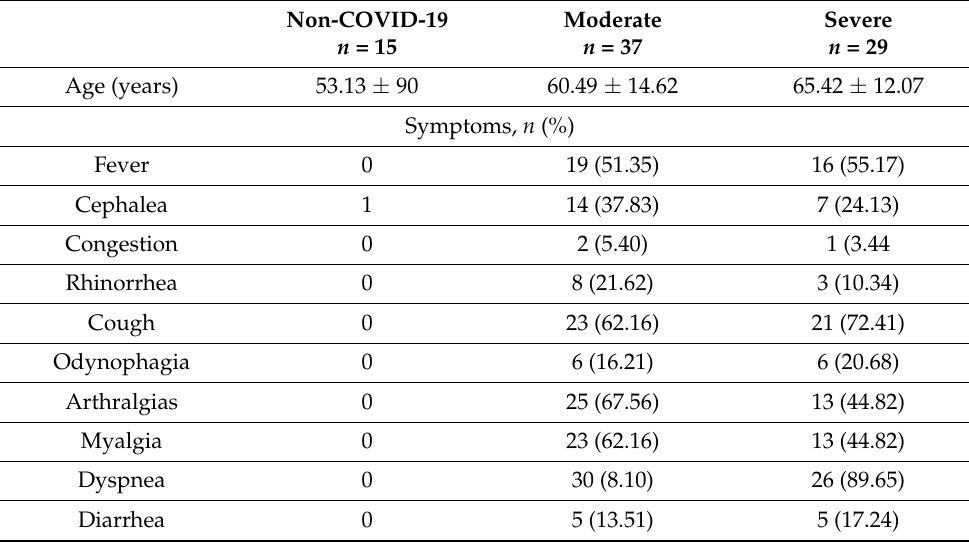
Table 1. Symptoms associated with COVID-19 in patients with moderate and severe disease.